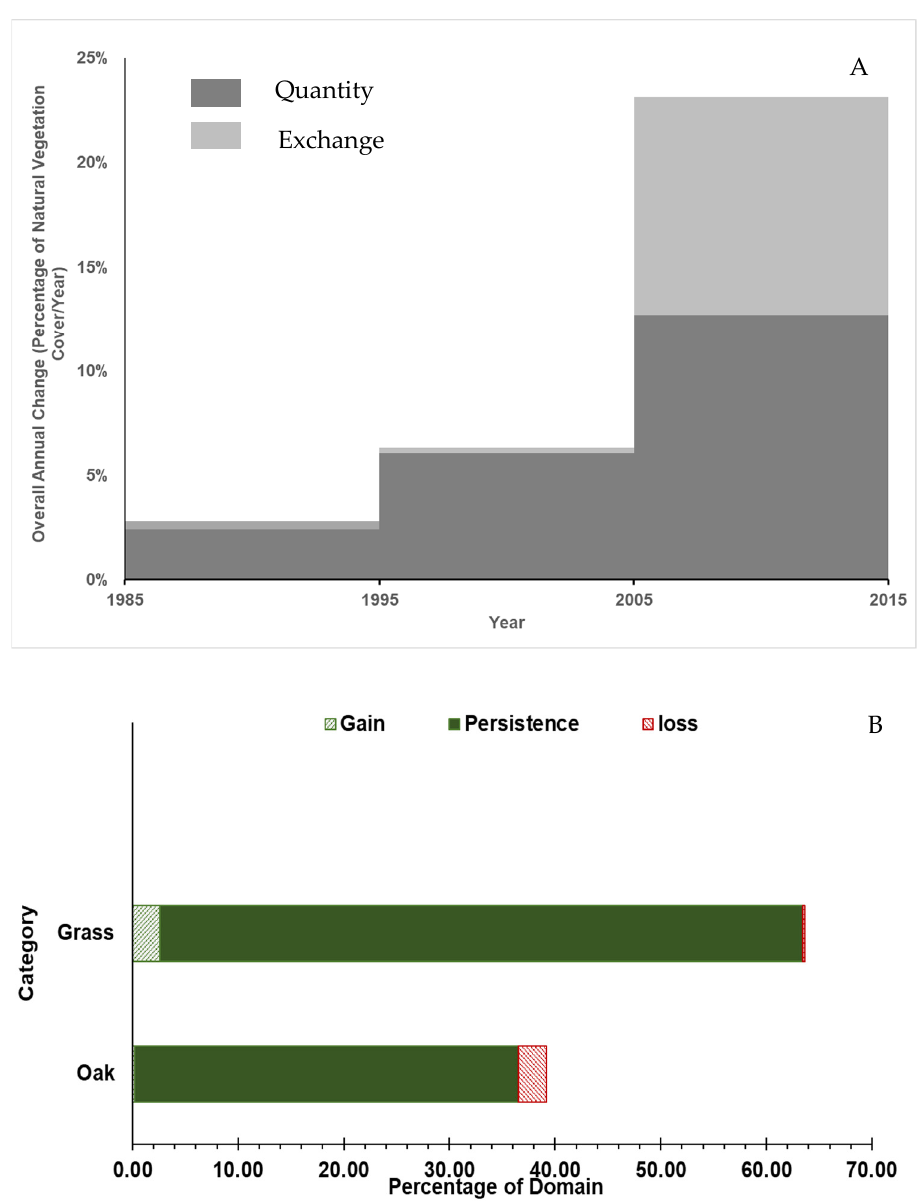
Figure 4. Shinnery oak and mixed grassland change between 1985 and 2015. ( A ) Overall quantity difference and exchange patters for all time intervals. ( B ) Overall patterns of gain, persistence (stable), and loss per vegetation cover class.